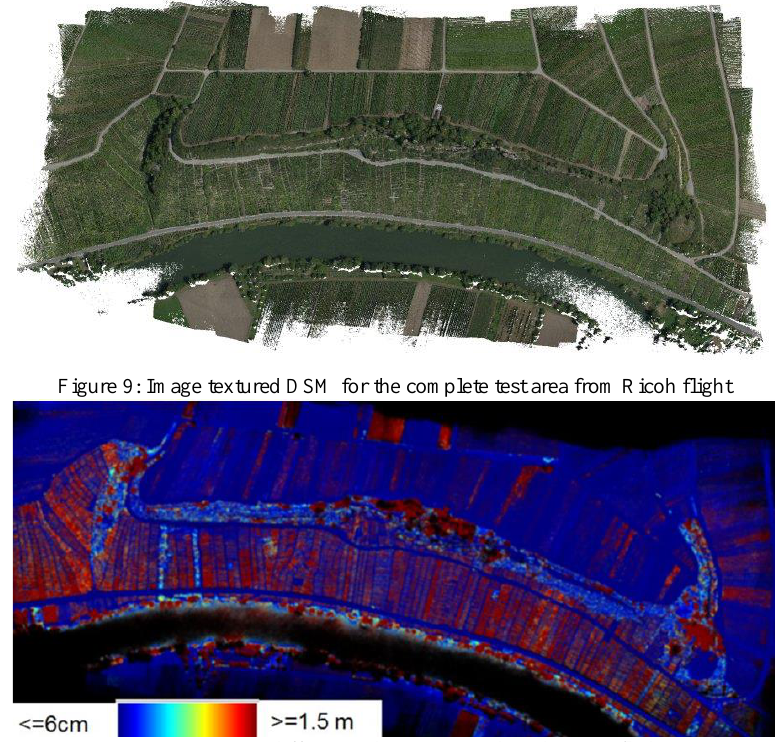
Figure 10: DSM differences between Ricoh and Canon